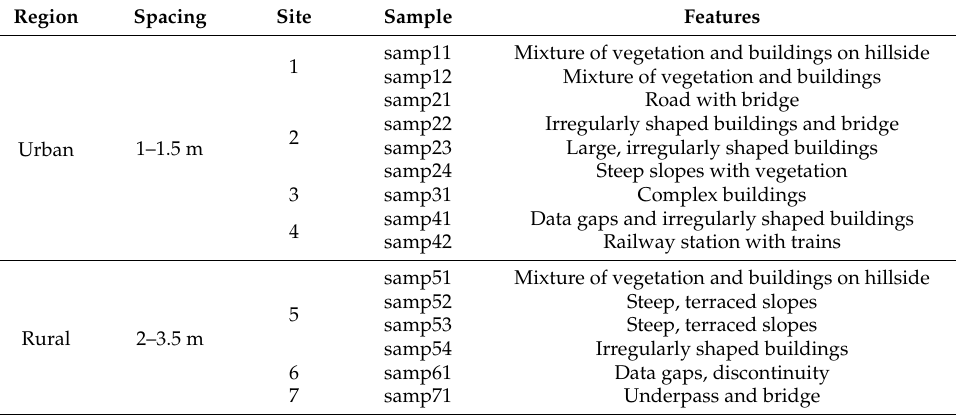
Table 1. Characteristics of all study